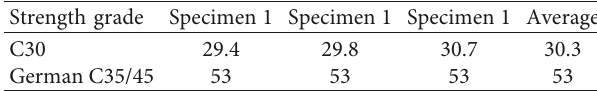
Figure 3: The dimension and details of the double-superposed shear wall: (a) W2 and (b) Table 1: Cubic compressive strength of concrete (MPa).